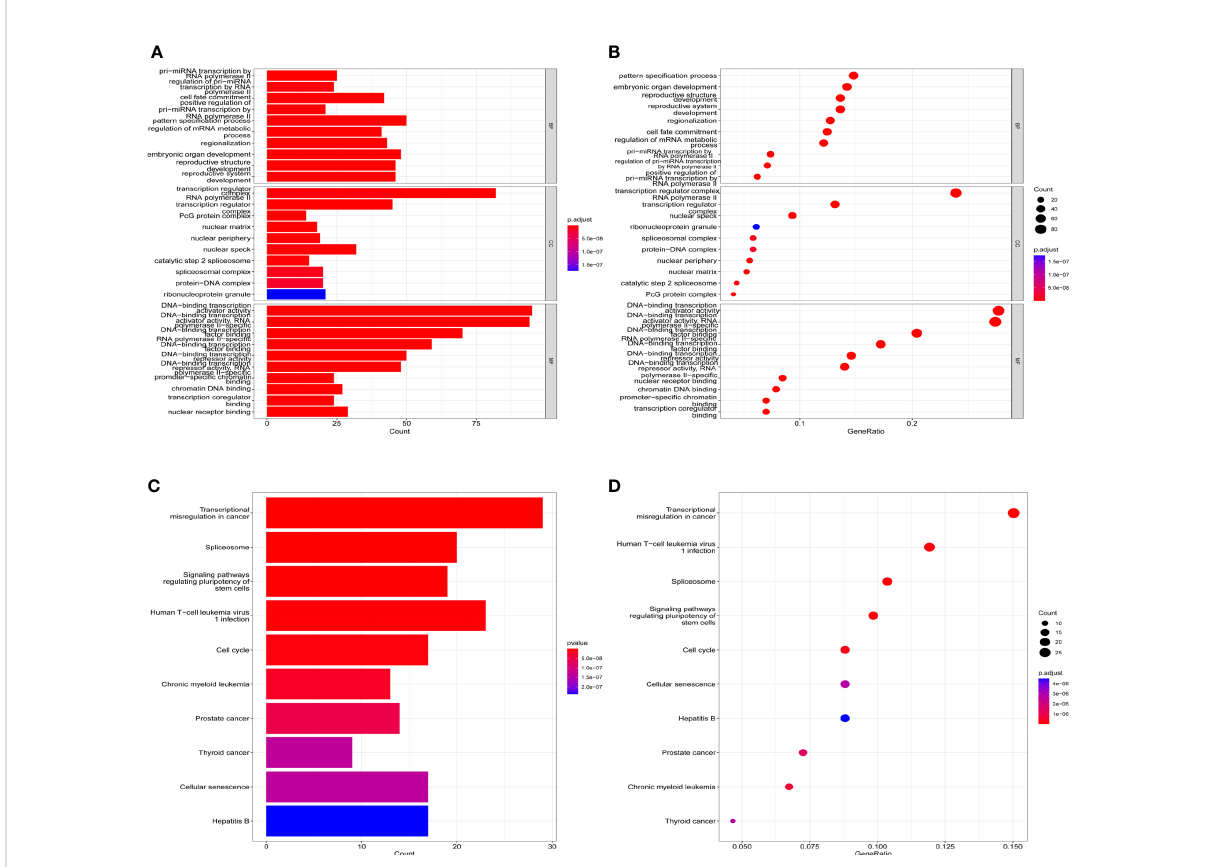
FIGURE 5 KEGG and GO term enrichment for HOXA-AS2. (A) Barplots of GO enrichment. (B) Bubble charts of GO enrichment; (C) Barplots of KEGG molecular mechanisms. (D) Bubble charts of KEGG molecular